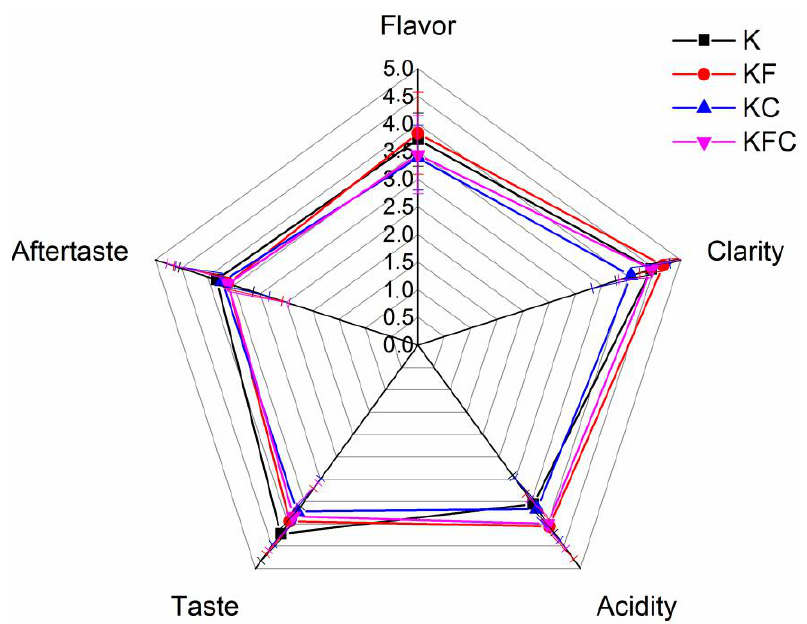
Figure 7. Sensory evaluation of kombucha on the 12th day of fermentation (K—control, KF— kombucha with algae extract, KC—kombucha with lichen extract, KFC—kombucha with a mixture of algae and lichen extracts).